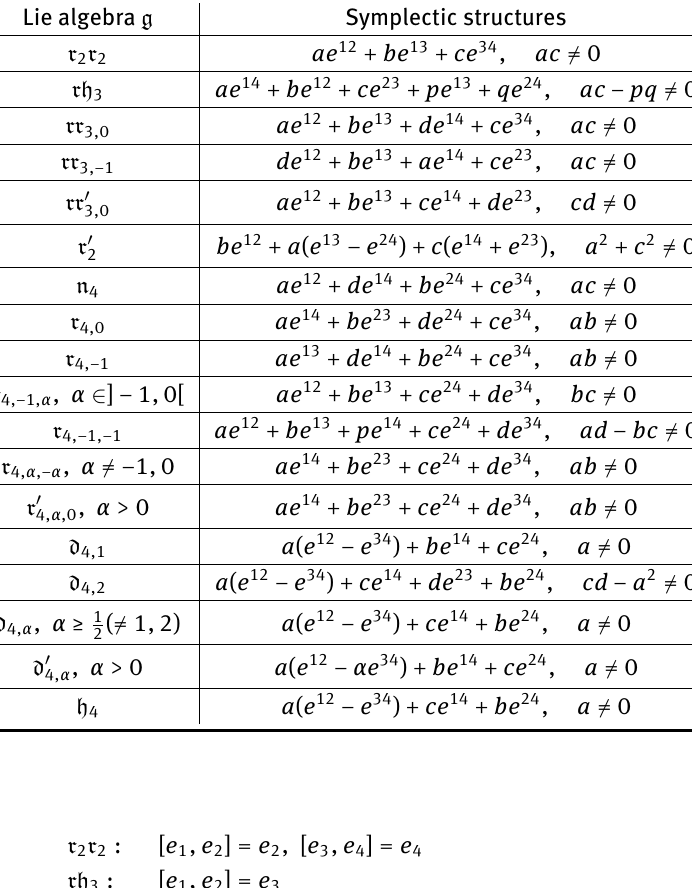
Table 1: Four-dimensional Symplectic Lie algebras. Lie algebra g Symplectic